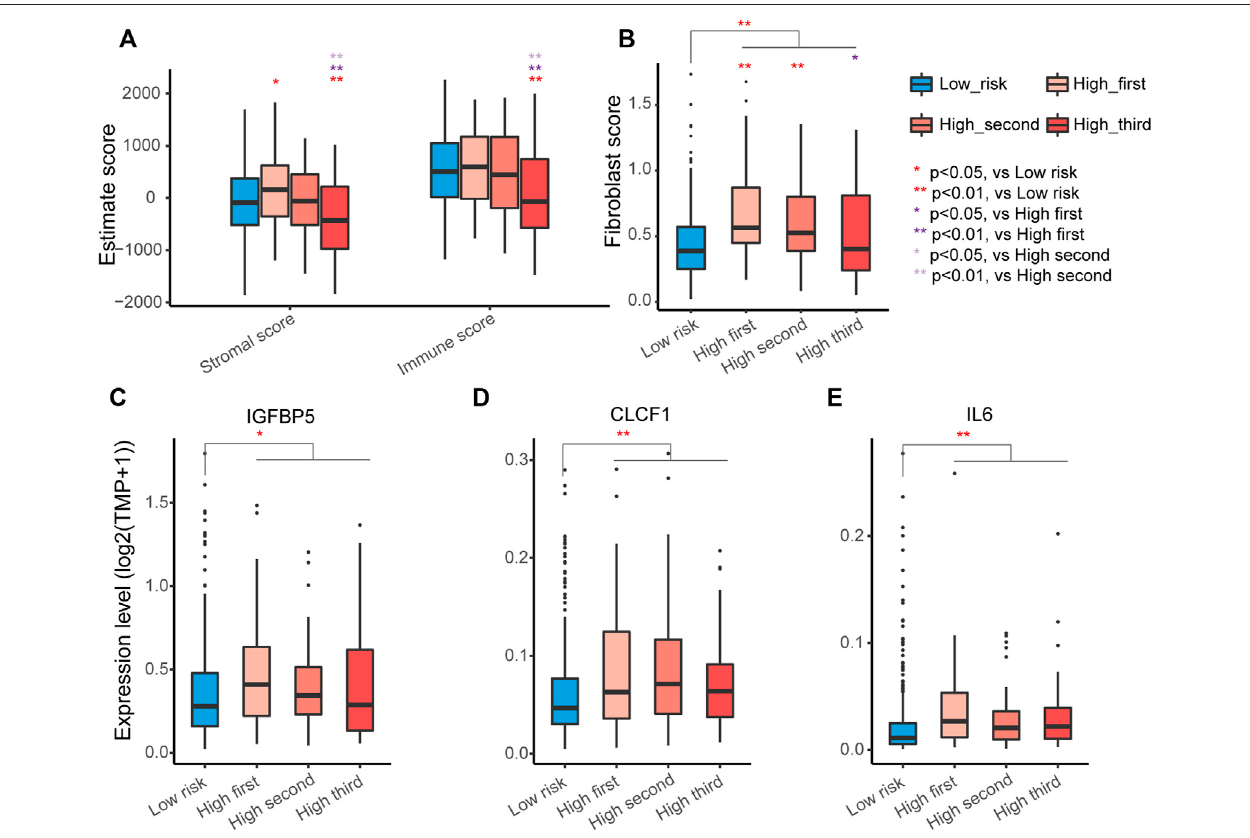
FIGURE 6 | Identi fi cation of immune heterogeneity underlying the ECM organization-related prognostic signature. (A) Differential expression of immune stromal score and immune score among different groups. The high-risk group was further divided into three groups according to the risk scores. The asterisks represent the statistical p values ( p p < 0.05; pp p < 0.01). (B) Differential expression of fi broblasts among different groups. (C – E) Different expression levels of factors secreted by the CAFs IGFBP5 (C) , CLCF1 (D) and IL6 (E)